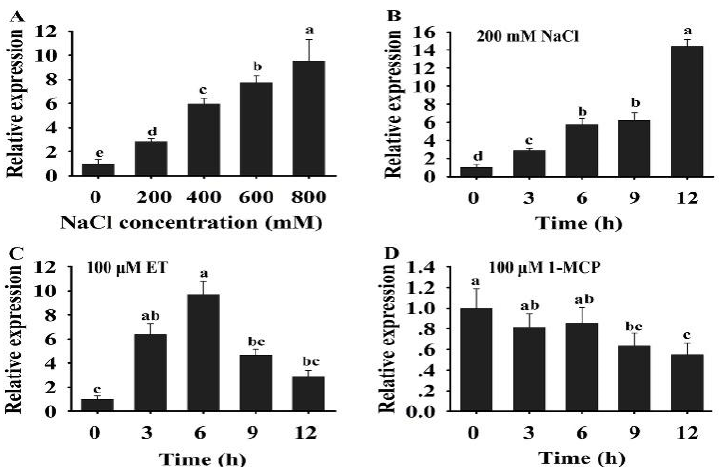
Figure 3. Expression analysis of HuERF1 under salt and ethylene treatments. ( A ) Expression pattern of HuERF1 in response to different concentrations of NaCl. Two-week-old pitaya seedlings were treated with different concentrations of NaCl (0, 200, 400, 600, and 800 mM). Total RNA was extracted from pitaya seedlings after NaCl treatment for 3 h and used for qRT-PCR. ( B–D ) Expression analysis of HuERF1 in response to NaCl, ET, and 1-MCP treatments. Roots of two-week pitaya seedlings were dipped in a mock solution or 200 mM NaCl ( B ), 100 µM ET ( C ), and 100 µM 1-MCP ( D ), and the seedlings were sampled after 0–12 h of exposure for qRT-PCR. The value at 0 h was set to 1. HuEF1- α was used as the internal standard. Different letters indicate a significant difference at p < 0.05, ANOVA followed by Fisher’s LSD test. Mean values and SDs of three biological replicates are shown.